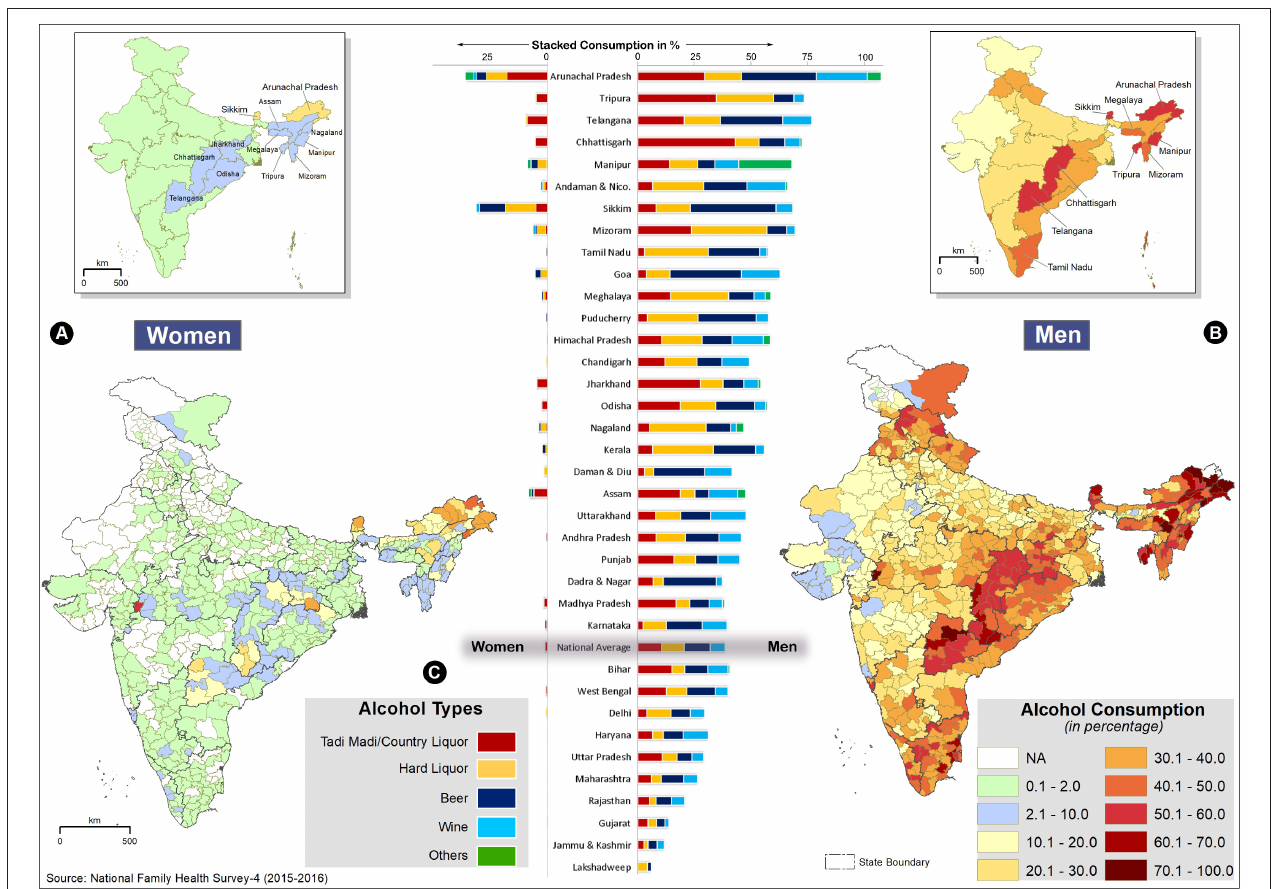
FIGURE 1 | State and district-wise comparison of alcohol consumption in men and women, National Family Health Survey (NFHS)-4. The inset maps (top) show the state-wise average, and the bottom maps show the district-wise alcohol distribution for women (A) and men (B) . The darker red shades denote higher consumption. The state boundaries are overlaid to show inter-intra state distributions. The state-wise comparison of different types of alcohol consumption is shown for men (right bars) and women (left bars) (C) . The colors in the bars indicate relative consumption (%) of different alcohol types.